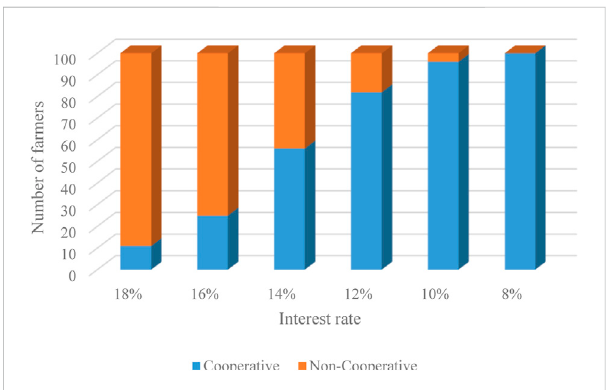
FIGURE 9 The level of cooperative and non-cooperative of farmers under social pressure and incentive policy